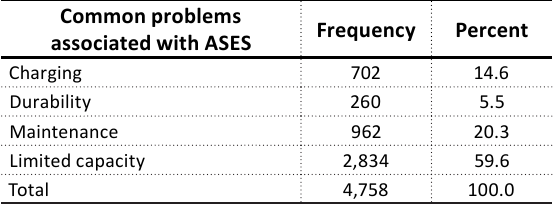
Table 19. Common problems associated with ASES